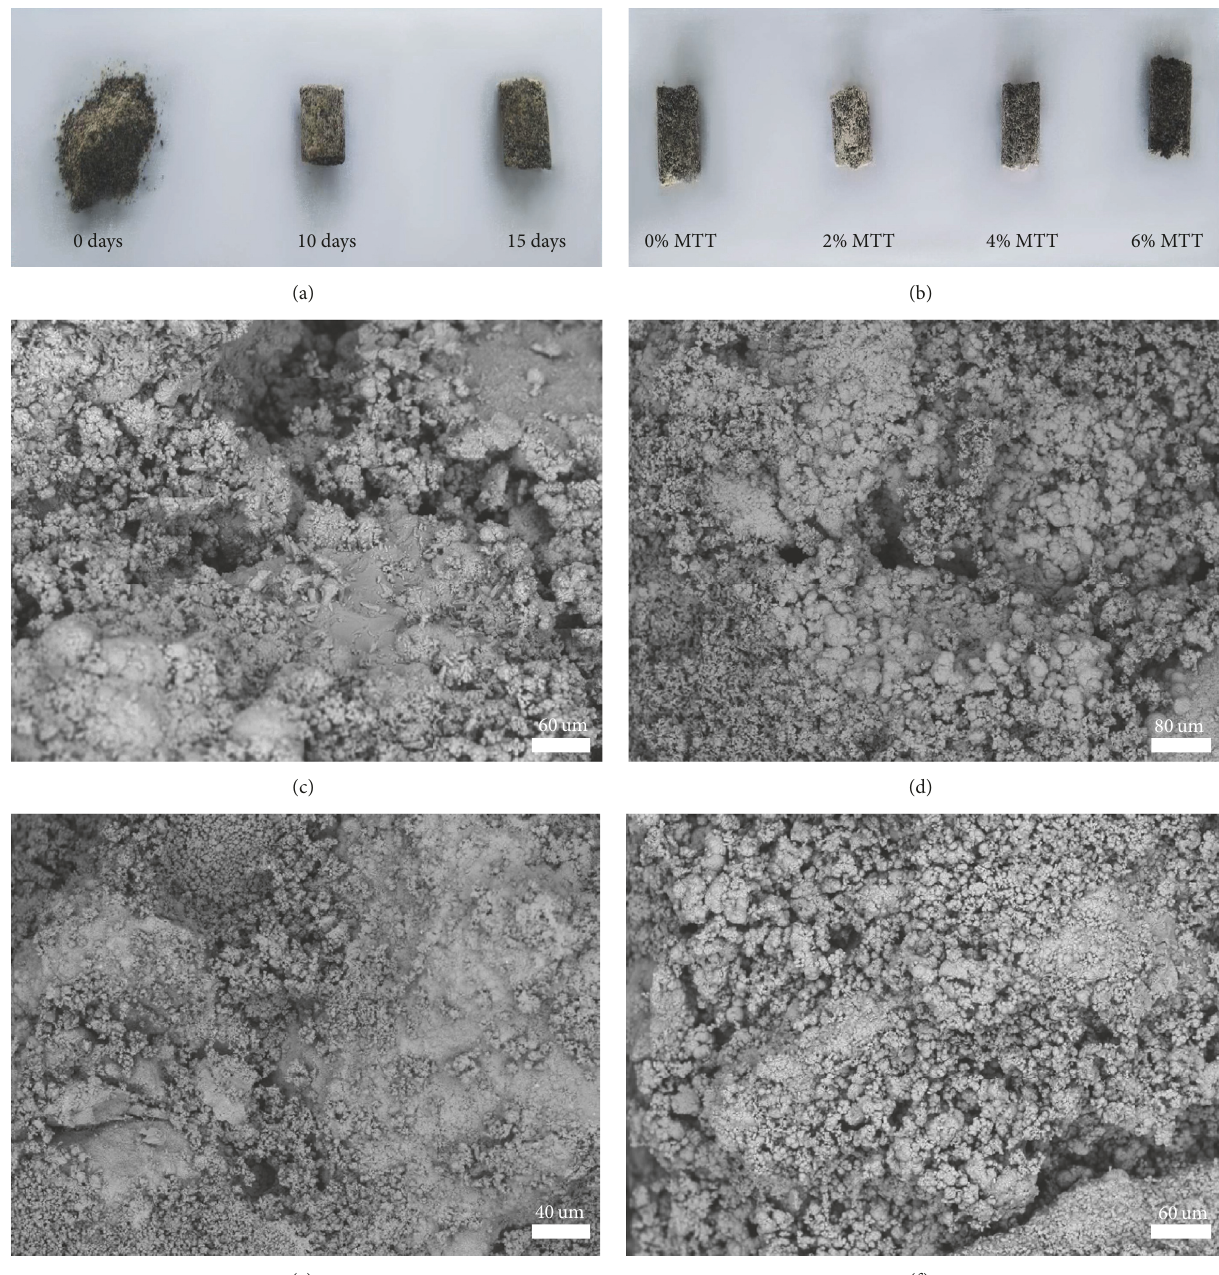
Figure 9: (a) The cemented sand column under different time conditions, (b) the cemented sand column by adding different amounts of MMT, and (c–f) typical SEM images of cemented sand